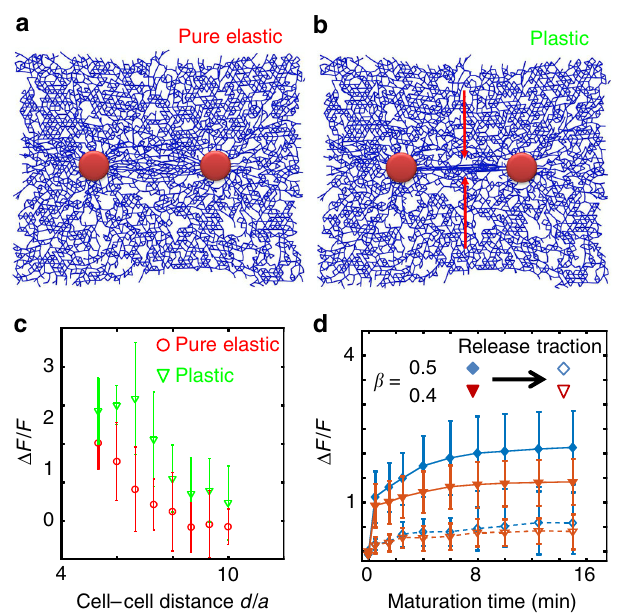
Fig. 2 Simulation of collagen bundle formation by contracting cell pairs. a The network con fi guration in an elastic model (without any sliding or merging events). b The network con fi guration predicted by our plastic model. c The relative increase of fi ber density Δ F / F of collagen bundles compared with the background at varying cell − cell distance. Here the cell − cell distance α is normalized by the cell size α . Red: plastic deformation with sliding events. Blue: pure elastic response of the network. At any given distance, the results from elastic ( T = 0 min) and plastic ( T = 15 min) are statistically distinct ( t -test, p = 0.0007, N = 8). d The irreversibility of a collagen bundle depends on both cell contractility ( β ) and maturation time T Δ F / F after the cell traction d . Here the irreversibility is characterized by force is released. The cell − cell distance is fi xed at d = 7 a . Error bars in c , d : mean ± SD, obtained from eight different